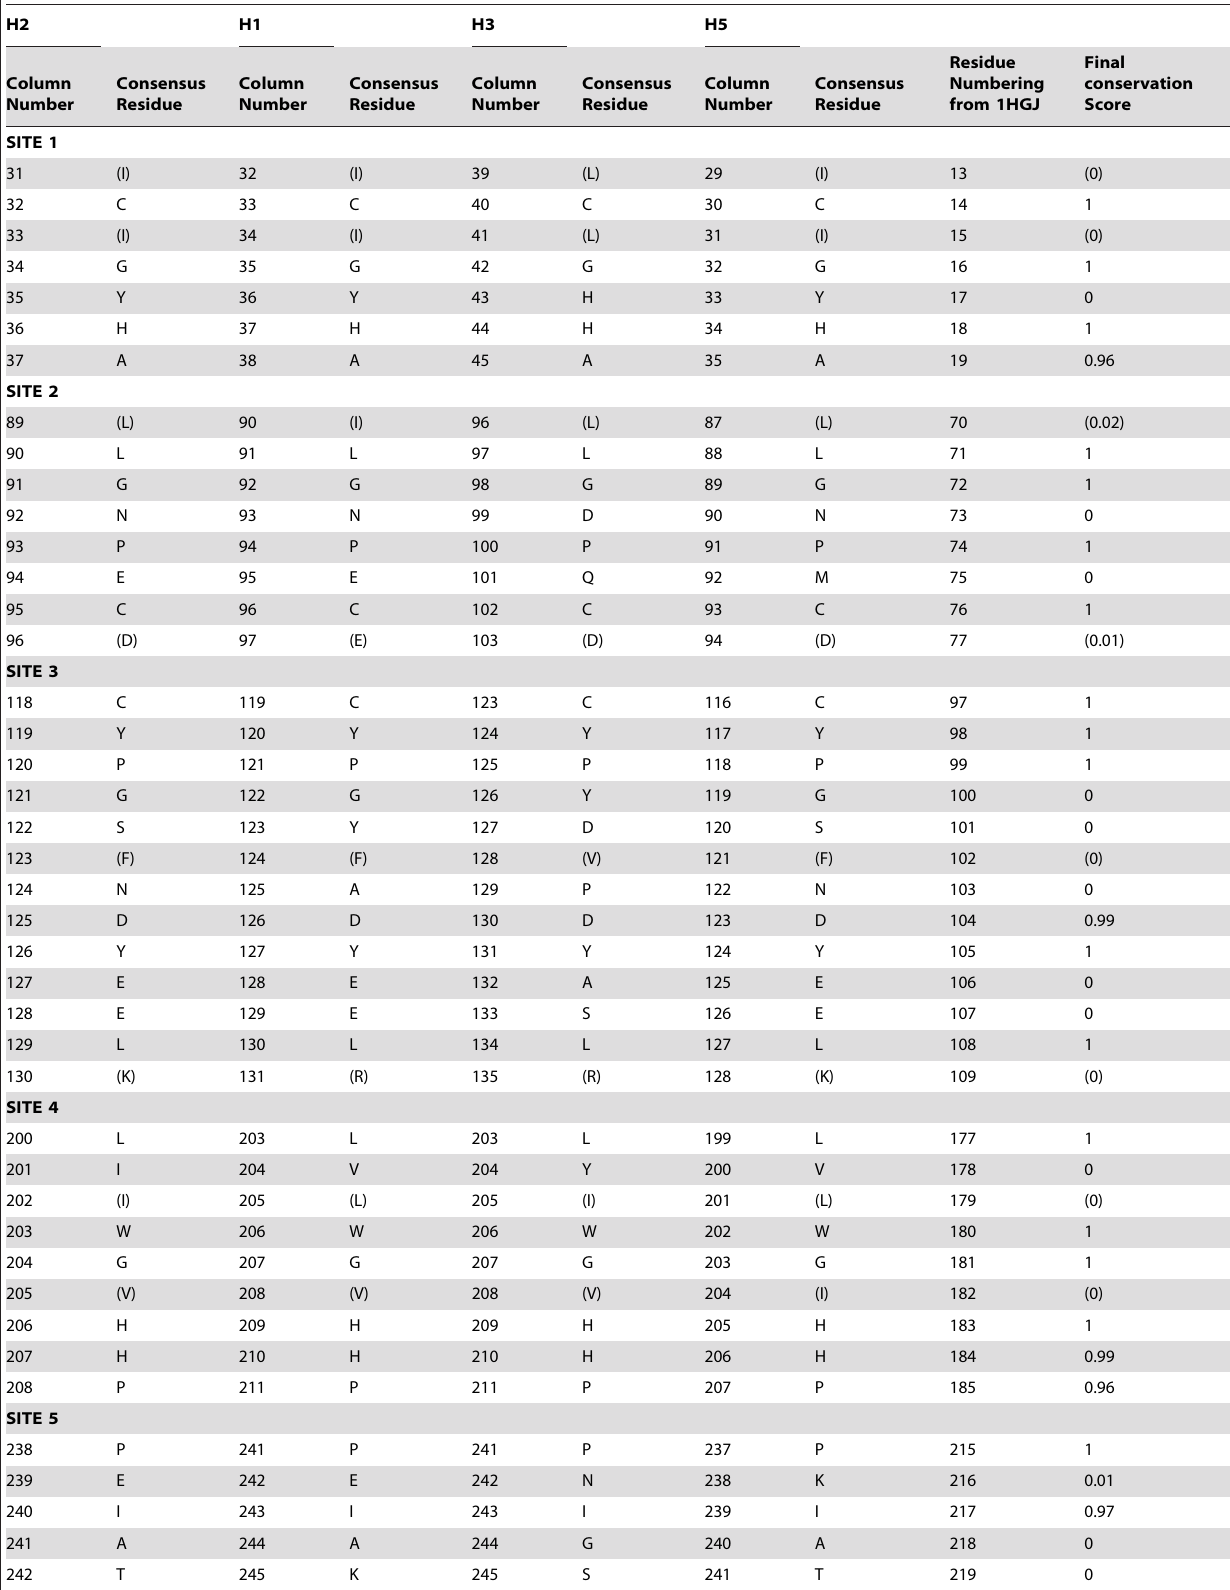
Table 1. Identified Influenza A conserved regions/sites